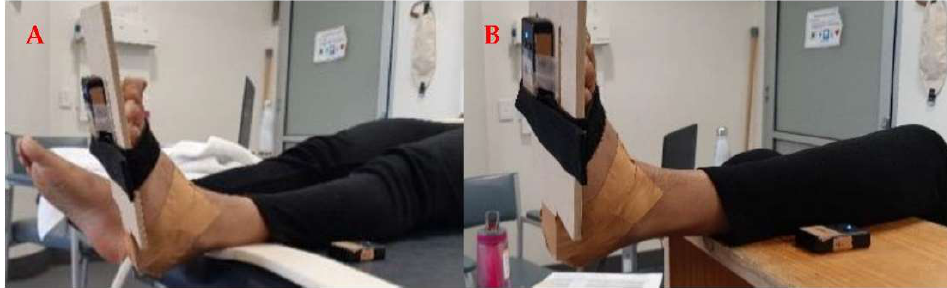
Figure 4. Participant position and sensor setup during the Tardieu spasticity assessment of the Gas- trocnemius ( A ) and Soleus ( B ).